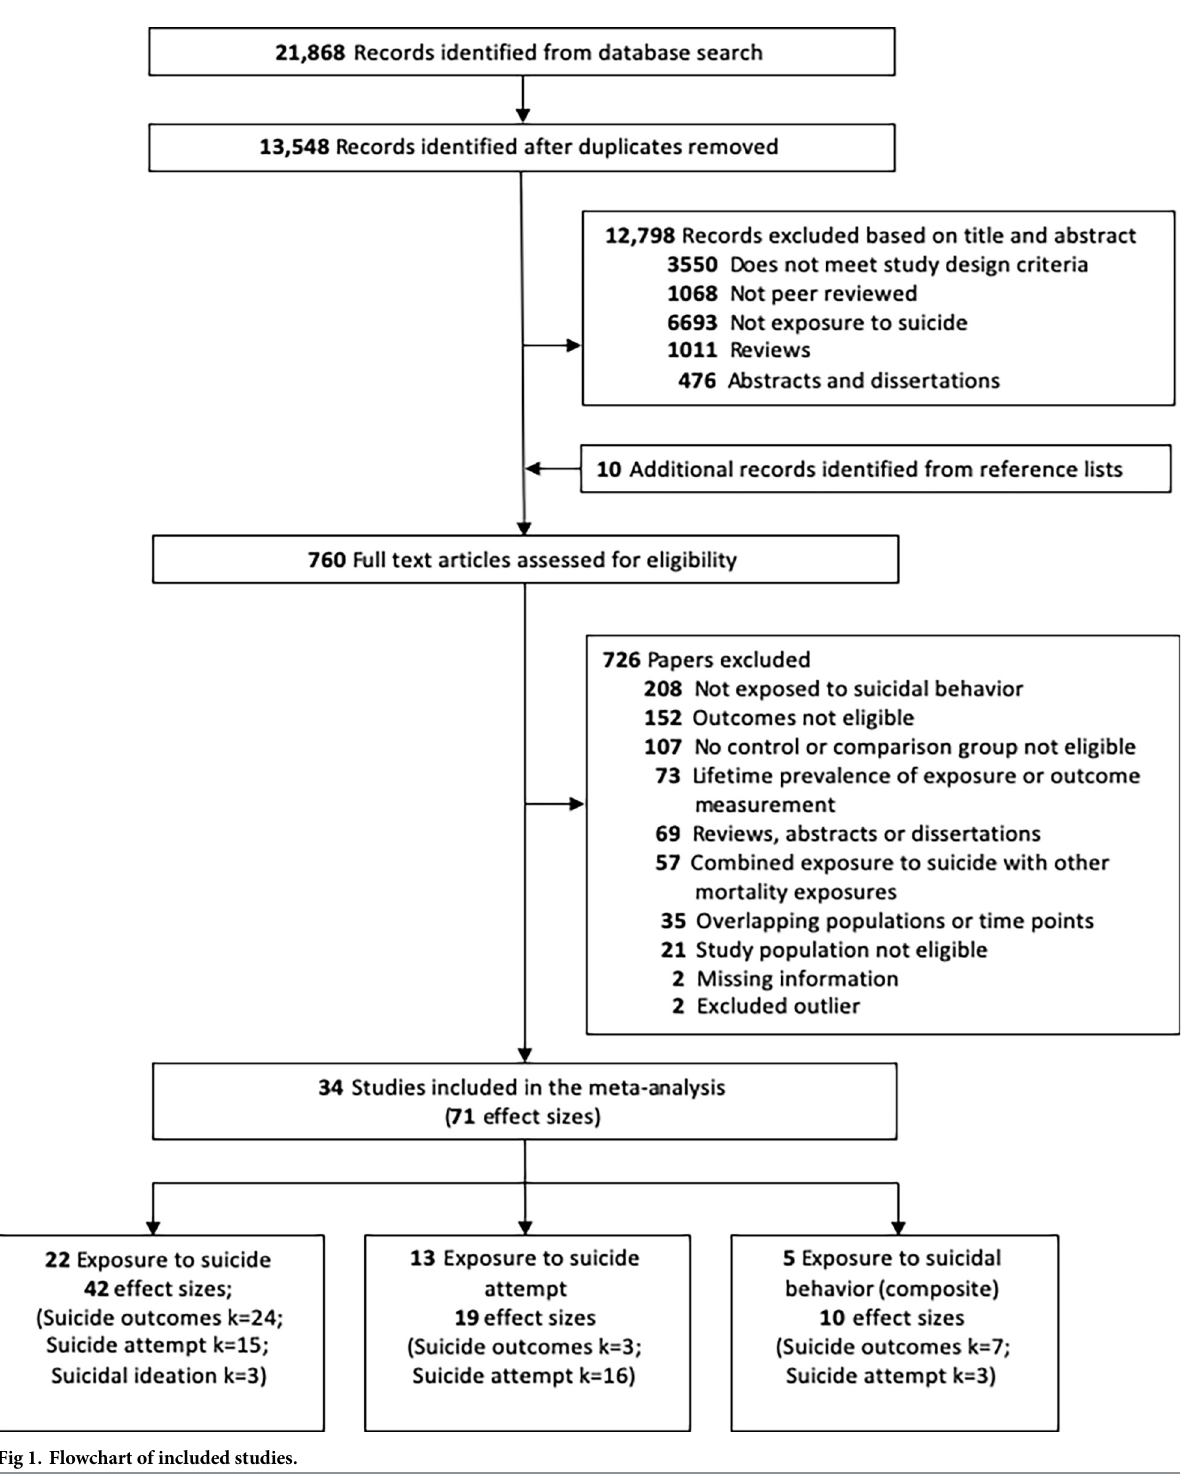
Fig 1. Flowchart of included